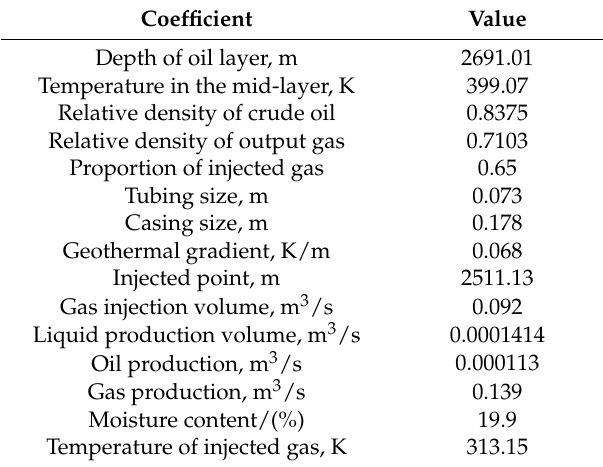
Table 7. Data for the Luo Wei Well.